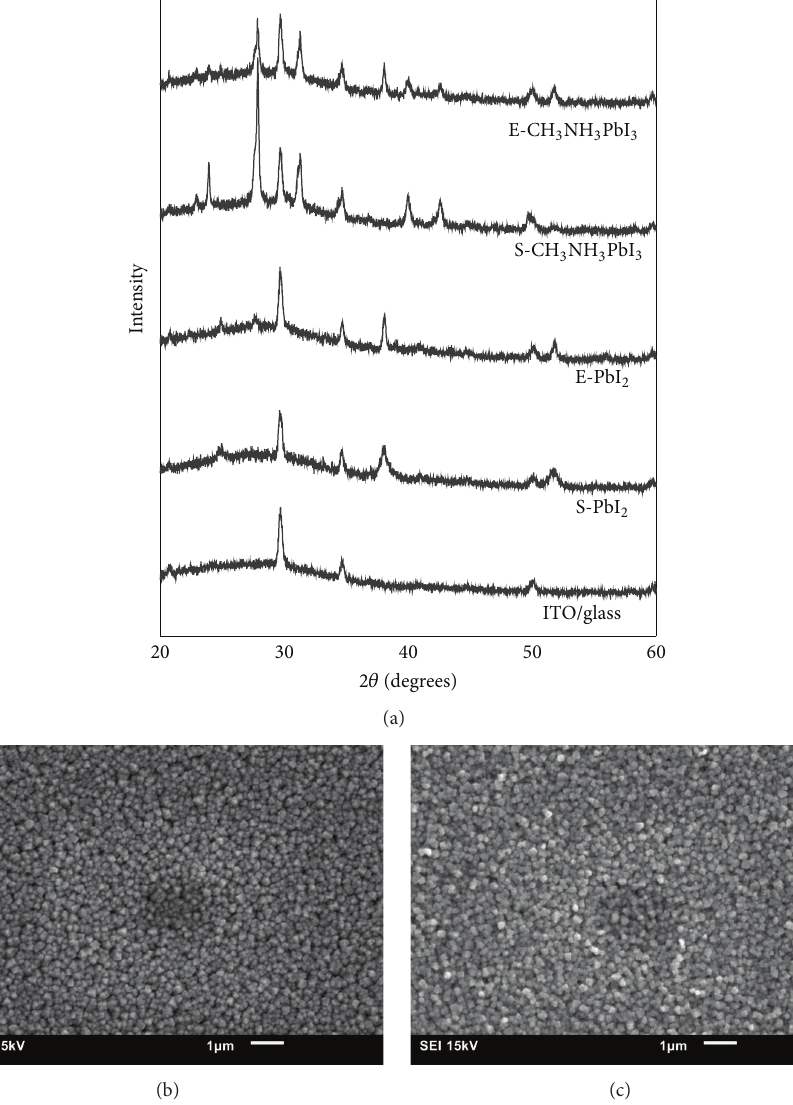
Figure 8: (a) XRD of evaporated and spin-coated layers. SEM of (b) spin-coated and (c) vapor deposited perovskite crystals. The XRD and SEM data suggest nearly identical crystal growth from spin-coating and vapor deposition of the PbI 2 layer. Reproduced from [23] with permission from the Royal Society of